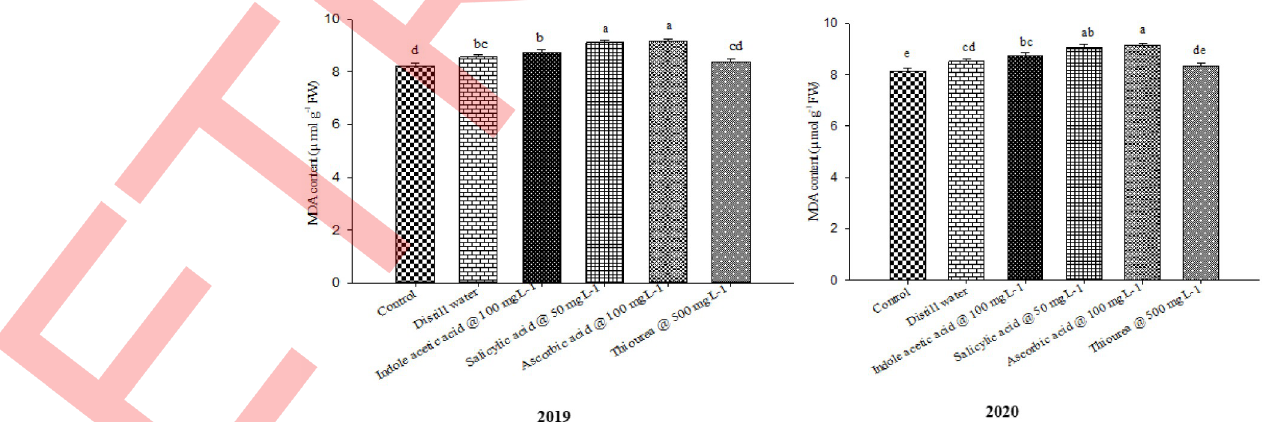
Fig 2. The influence of seed priming with different growth regulators on MDA contents of Indian squash. The error bars represent ± standard error of the means. Alphabets on bar showed a significant difference ( P � 0.05) among seed priming